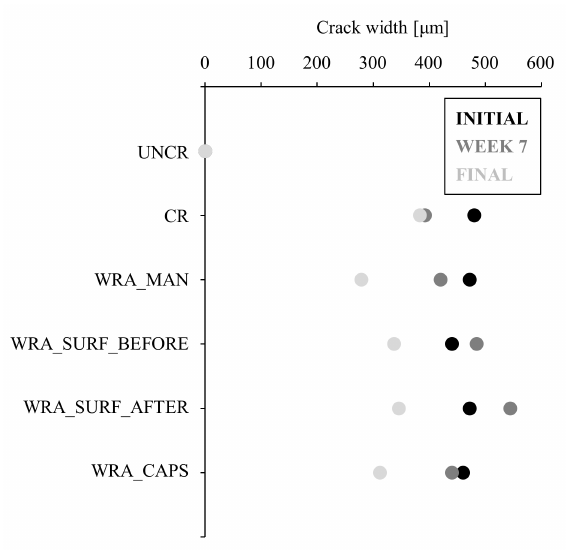
Figure 6. Mean crack width measured for each of the test series at different time